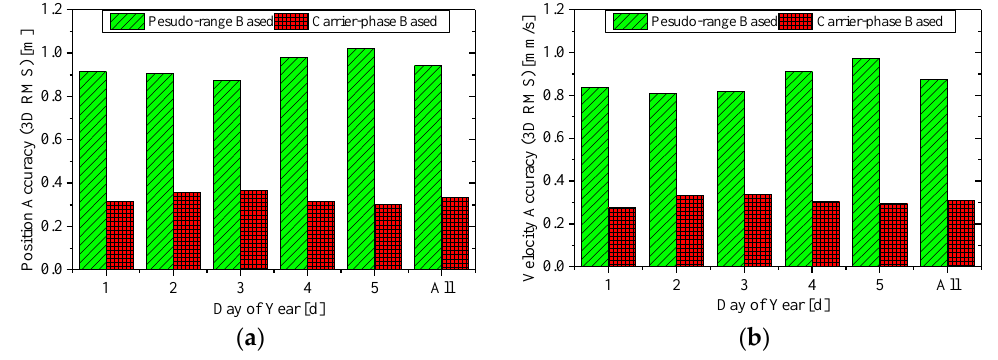
Figure 4. The accuracy (3D RMS) of real-time orbits for the HY2A satellite. ( a ) The position accuracy; and ( b ) the velocity accuracy.